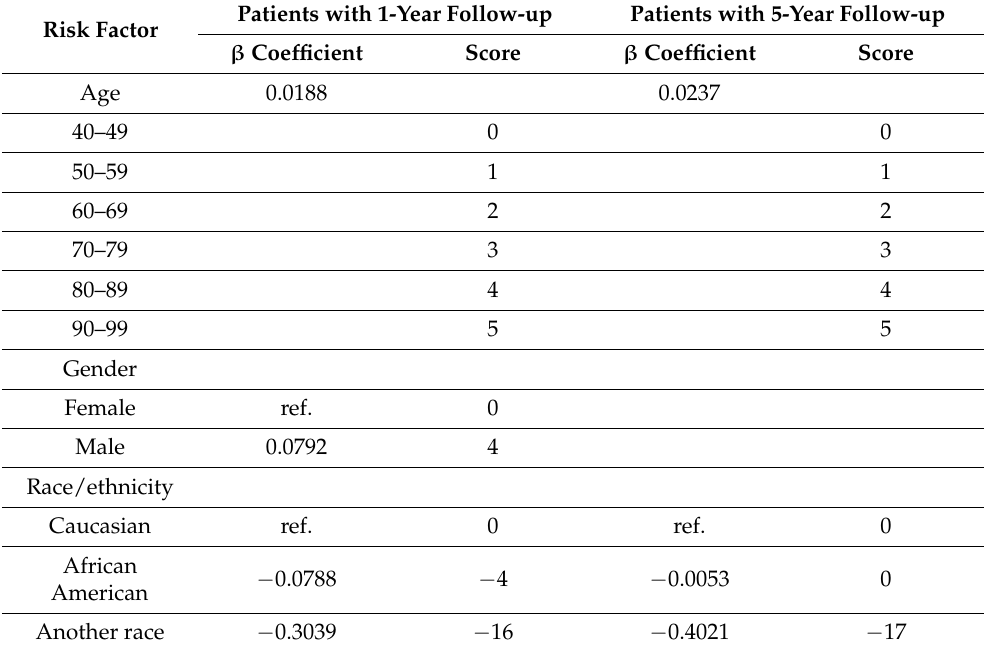
Table 3. Score system for AS patients with 1-year and 5-year follow-up. Risk